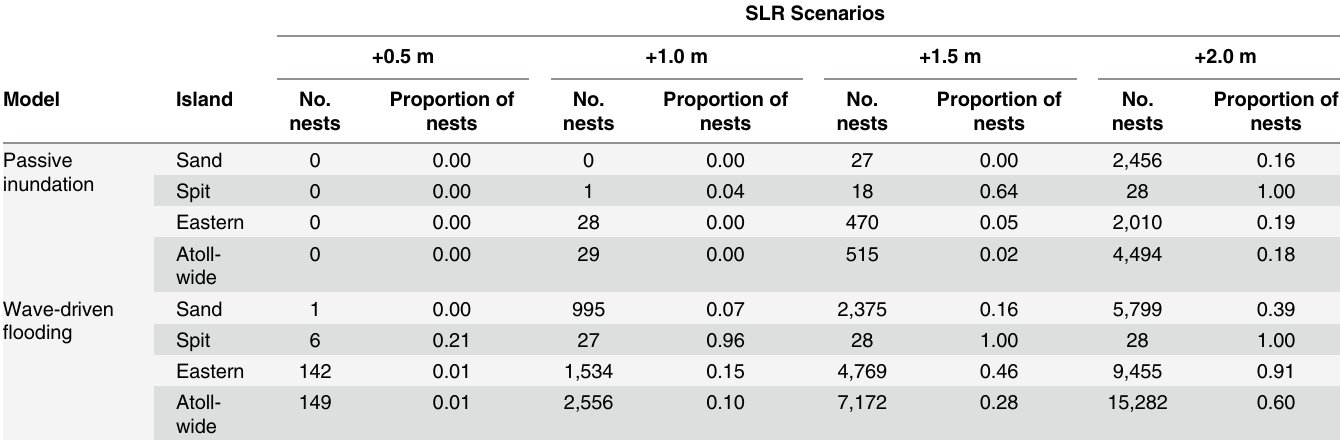
Table 5. Projected black-footed albatross nest inundation at Midway Atoll for four sea-level rise scenarios and two inundation models, including groundwater rise. Nest distribution and abundance based on the 2011/2012 breeding season nest census at Sand (15,002 nests), Spit (28 nests), and Eastern (10,413 nests) islands, totalling 25,443